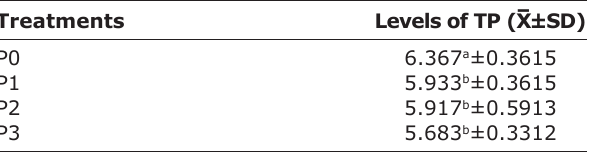
Table-3: Mean and SD of the white rats’ ( R. norvegicus ) total blood serum proteins after treatments. Treatments